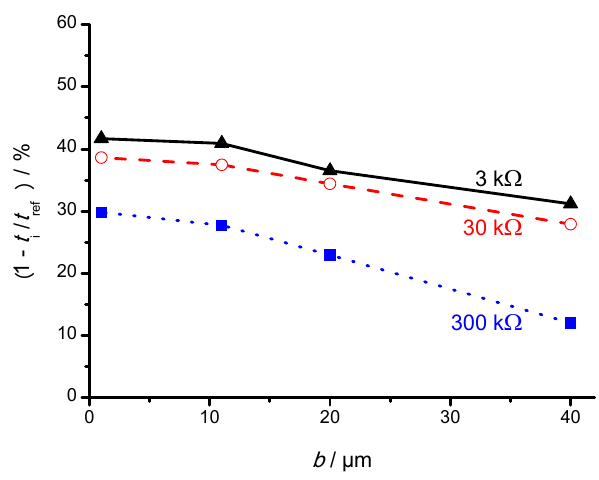
Figure 7. Simulated percentaged reduction of the initiation time t i for di ff erent layer thicknesses and conductivities, see Table 1. t ref is the initiation time of the uncoated sensor.